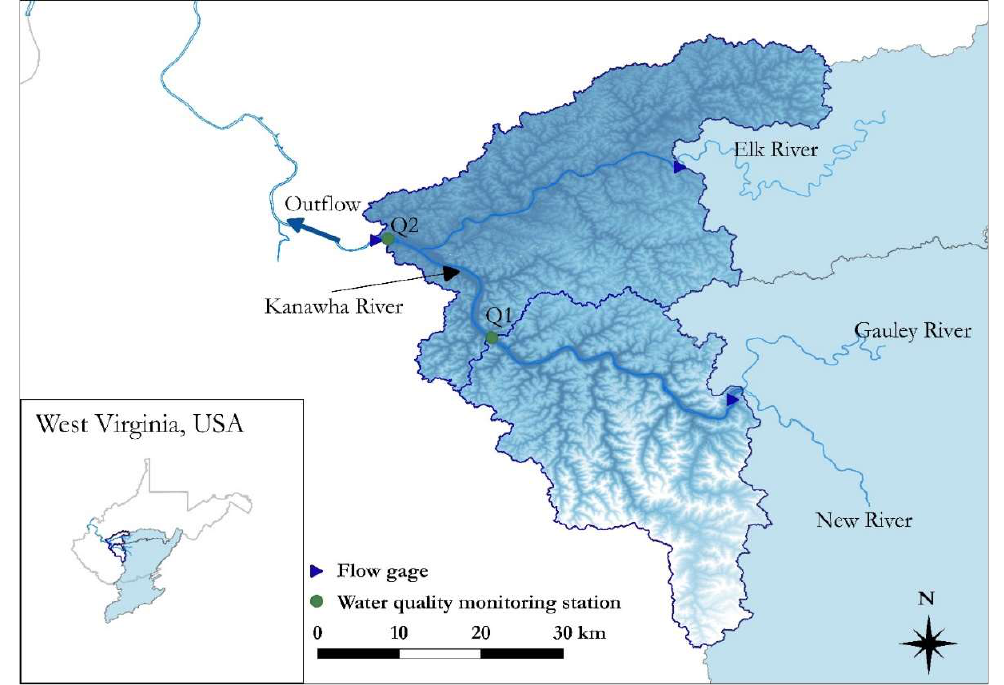
Figure 1. Catchment area of the Kanawha River, West Virginia, indicating location of flow gages and water quality monitoring stations.